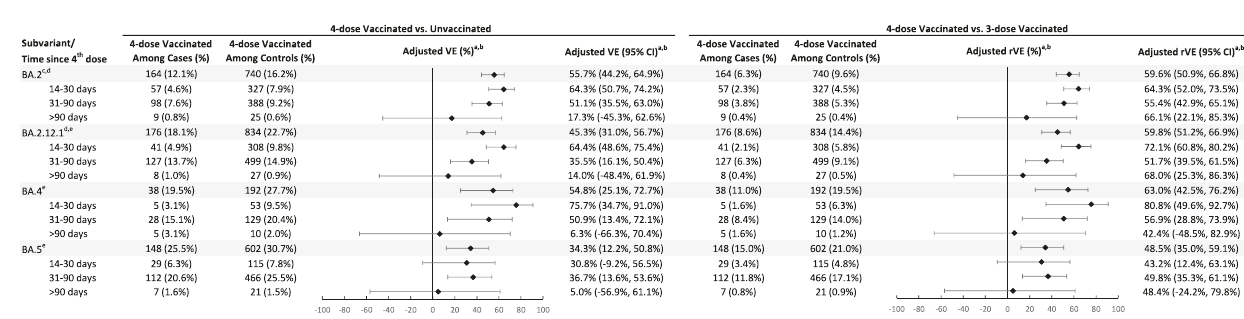
Fig. 3 | Adjusted vaccine effectiveness (VE) and relative vaccine effectiveness (rVE) of mRNA-1273 against infection with omicron subvariants by time since 4thdosevaccination. AdjustedVEoffourdosesofmRNA-1273andadjustedrVEof four versus three doses of mRNA-1273 and their 95% con fi dence intervals against infection with SARS-CoV-2 omicron subvariants. Sample size for each analysis equalsthenumberof four-dose vaccinated divided by the percentage offour-dose vaccinated. Symbols represent the adjusted vaccine effectiveness or adjusted relative vaccine effectiveness. a When the OR or its 95% CI was >1, the VE/rVE or its 95%CI wastransformedas([1/OR] – 1)×100. b Adjustedforage,sex, race/ethnicity,